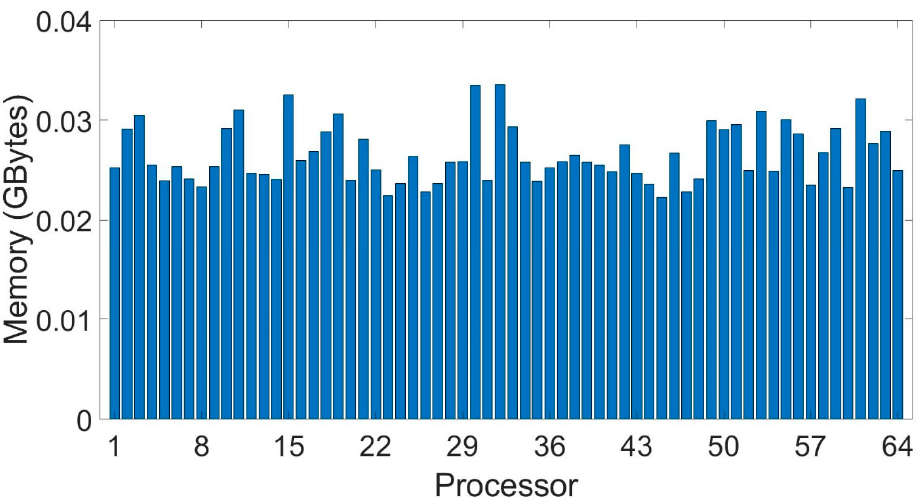
Figure 15. Testcase#1. The Compression versus the Accuracy for various proposed techniques.